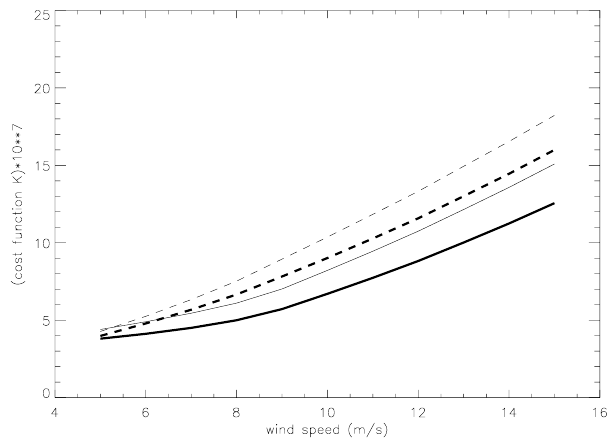
Figure 3. Cost function K times 10 7 , as defined by equation (32), corresponding to the model of this paper (thick lines), compared with the cost function K obtained in the classical approach (thin lines), as a function of wind speed. The sea wave spectral models and source terms are the same as in Figure 2, involving high wavenumber spectrum from Elfouhaily et al. (1997) (solid lines), or from Kudryavtsev et al. (2003) (dashed lines).